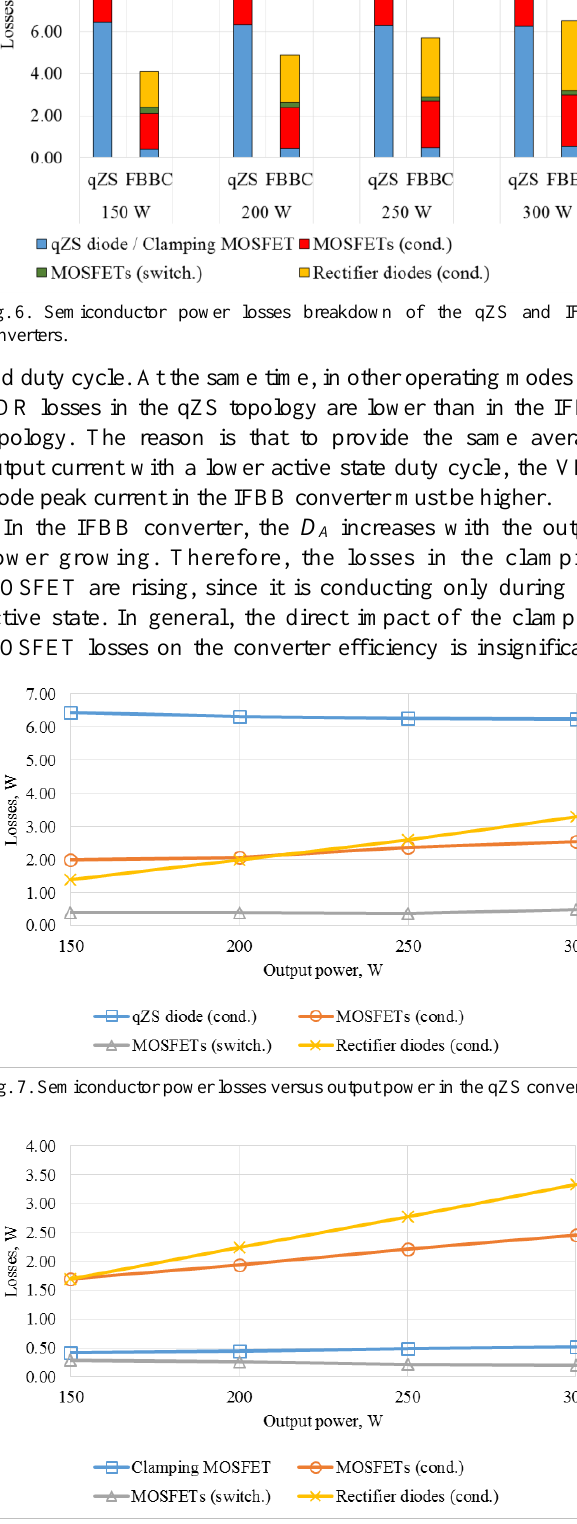
Fig. 8. Semiconductor power losses versus output power in the IFBB converter.